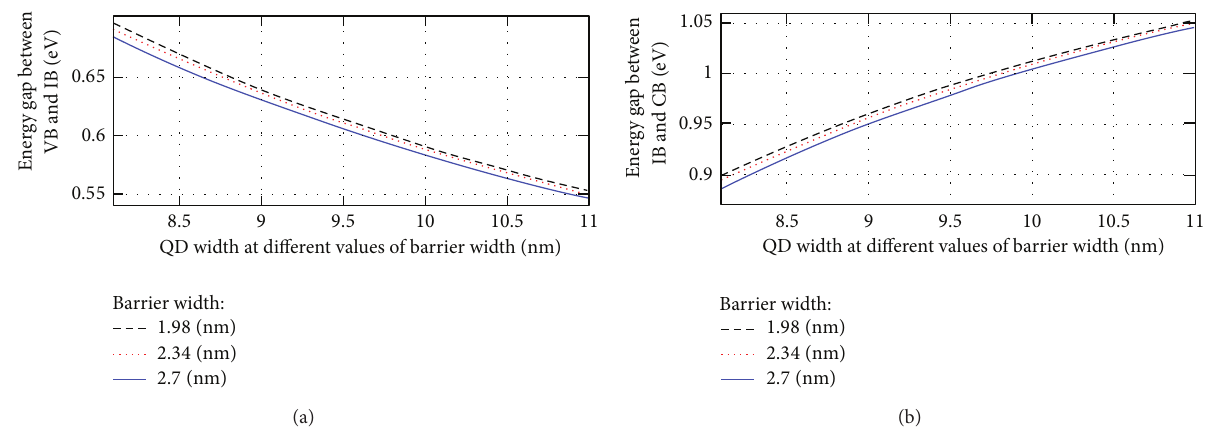
Figure 9: (a) Change energy gap between VB and IB according to change in QD width for the second allowable range at different values of barrier width. (b) Change energy gap between IB and CB with the same conditions in (a).